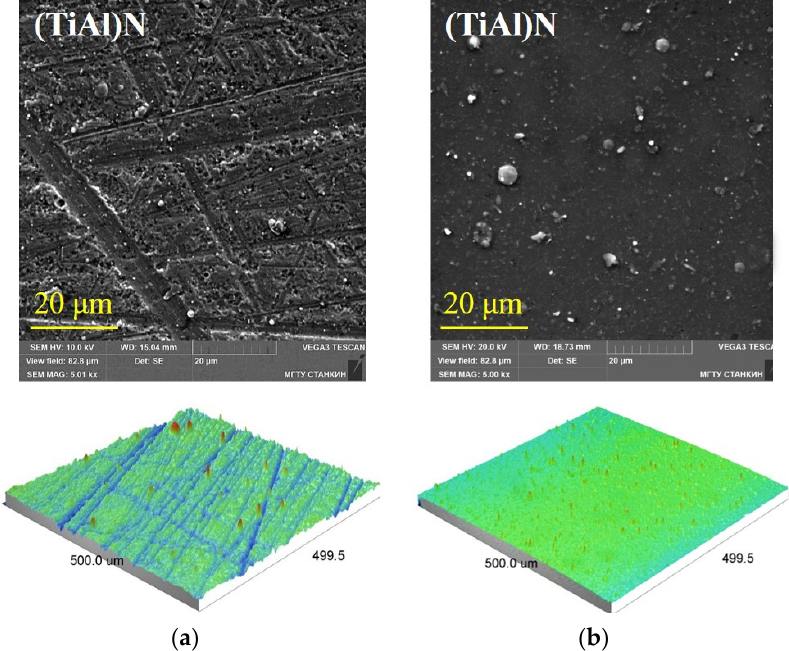
Figure 8. SEM images of the microstructure and 3D profilogram of (TiAl)N coatings deposited on Al 2 O 3 +TiC ceramic inserts with different surface layer conditions after diamond grinding ( a ) and after diamond grinding, lapping and polishing ( b